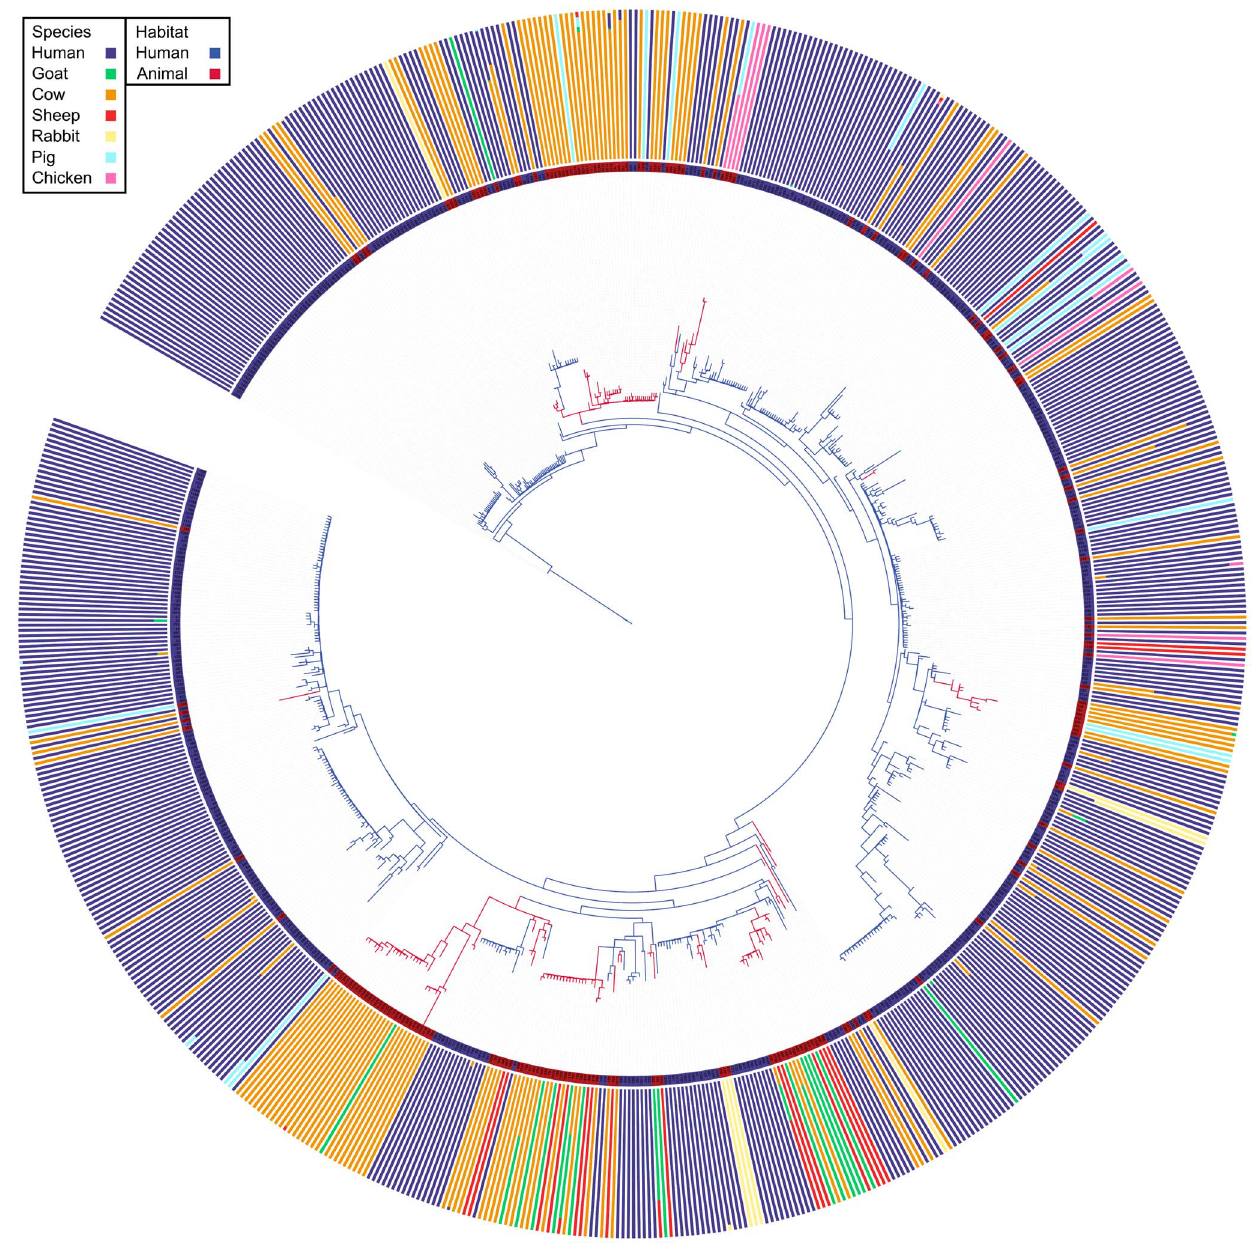
Figure 1. A maximum likelihood phylogeny of 696 MLST STs derived from human and animal hosts. Branch colours describe habitat associations inferred by AdaptML (Human – Blue, Animal – Red). External bars represent the normalised proportions of isolates from each of the seven species for each ST. Internal colours represent the most common source of isolation for each ST, this is used as the ecology marker in the AdaptML inputs. (Human – Blue, Animal – Red).